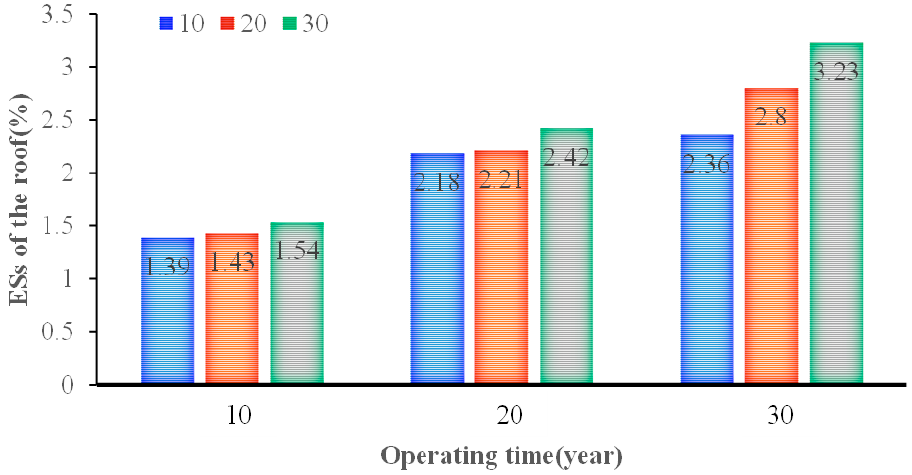
Figure 19. Equivalent strain of the cavern roof with different well spacings at different times.